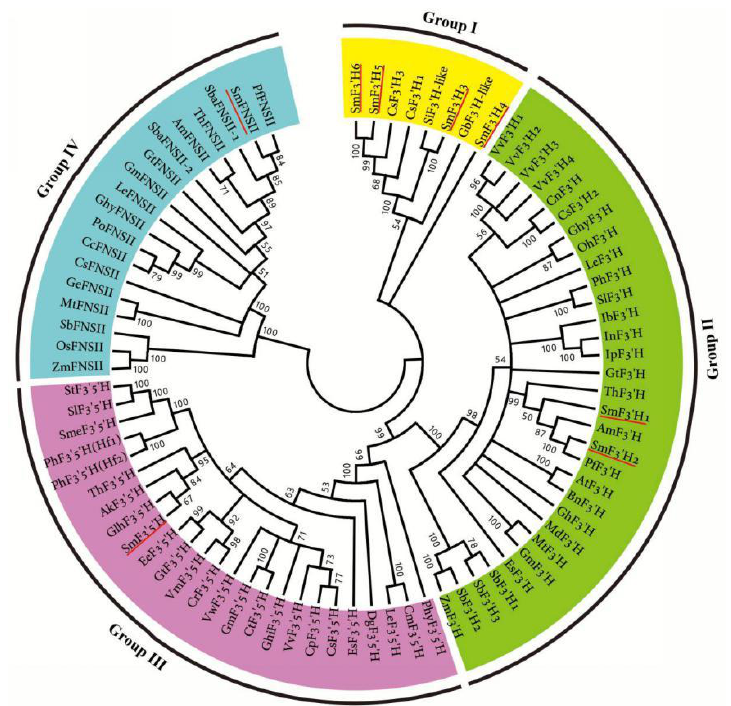
Figure 5. The phylogenetic relationship of FNSII, F3′5′H and F3′H proteins. The amino acid sequences of flavonoid biosynthesis-related P450s, including FNSII, F3′5′H and F3′H were obtained from NCBI of flavonoid biosynthesis-related P450s, including FNSII, F3 (cid:48) 5 (cid:48) H and F3 (cid:48) H were obtained from NCBI under the accession numbers listed in Supplementary Table S6. under the accession numbers listed in Supplementary Table